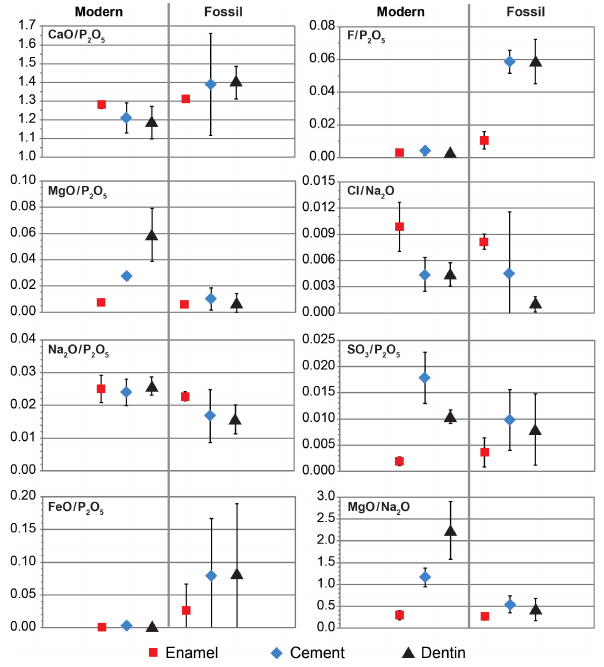
Fig. 3. Comparison of the average chemical compositions of all modern and fossil molar tooth materials from